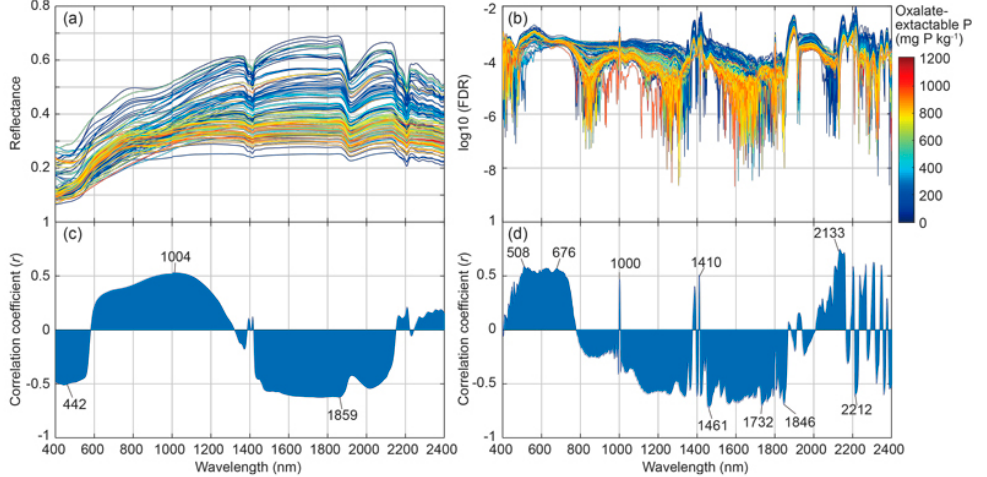
Figure 4. Raw reflectance spectra ( a ) and first derivative reflectance (FDR) spectra on a log10 scale ( b )